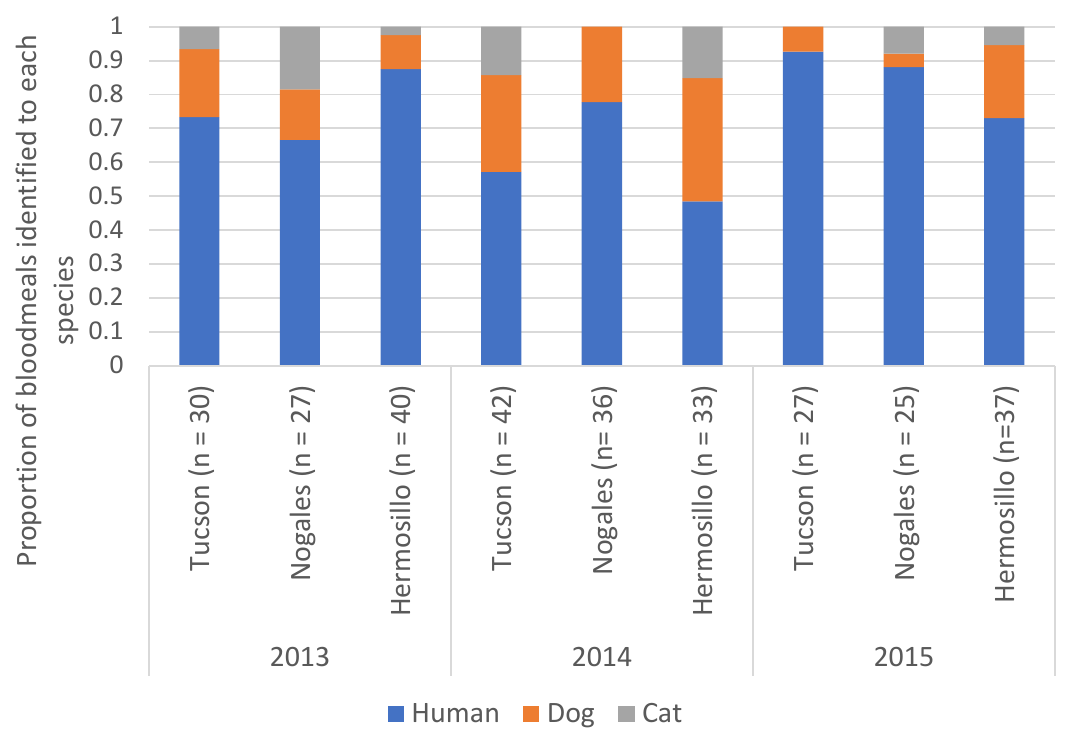
Figure 6. Bloodmeal analysis conducted on engorged female Ae. aegypti mosquitoes from trapping events in Tucson, AZ, Hermosillo, SN, and Heroica Nogales, SN from 2013 – 2015. The proportion of mosquitoes found with blood of each mammalian species. No significant differences by city. 2014 had significantly less human bloodmeals than the other years.